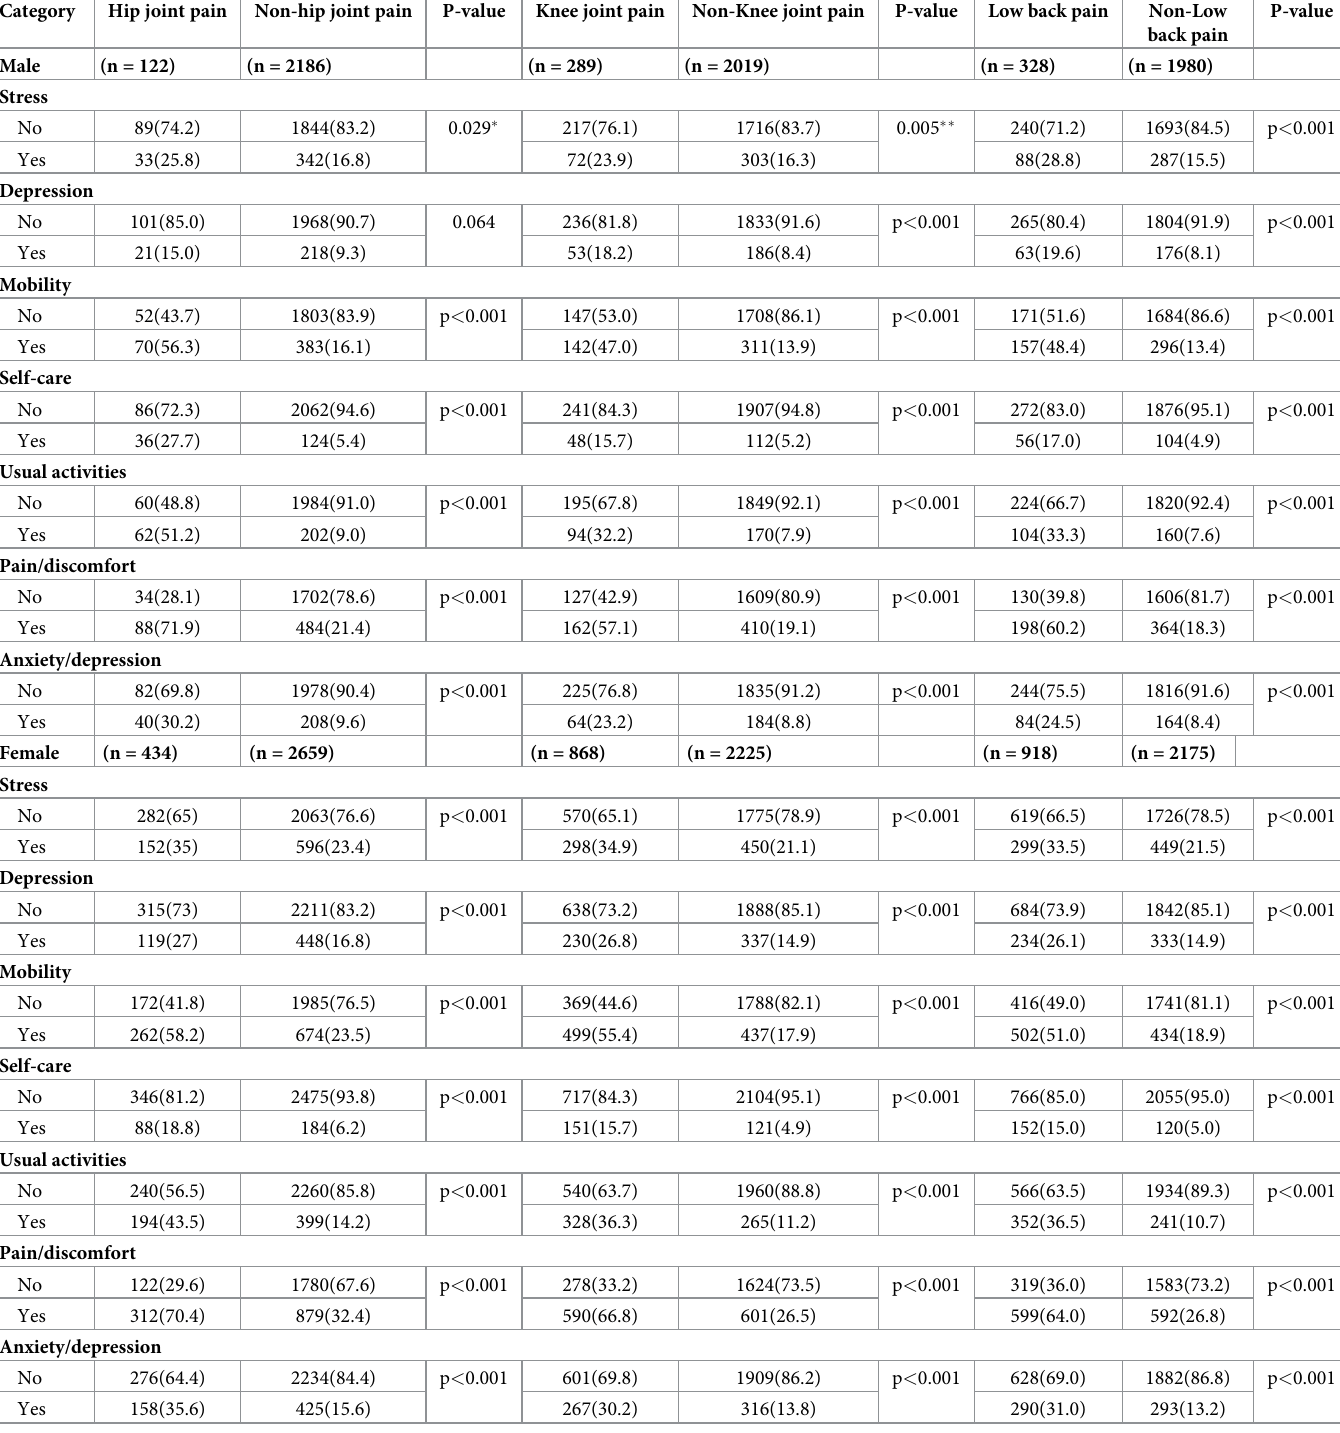
Table 2. Characteristics of the mental health and quality of life according to the osteoarthritis pain site and